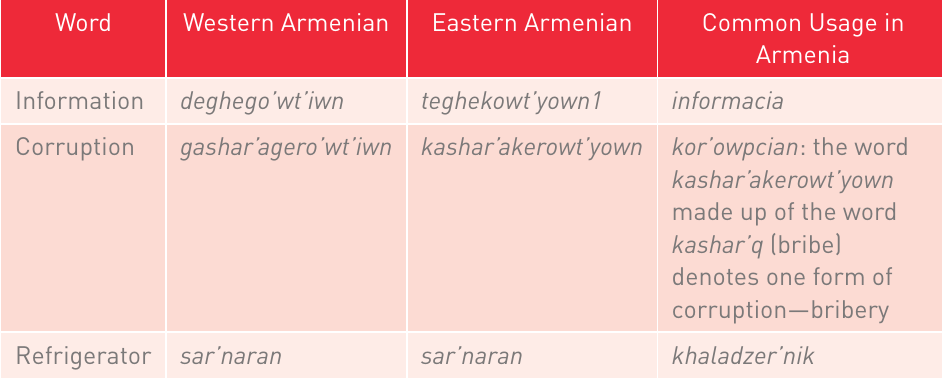
Examples of foreign loan